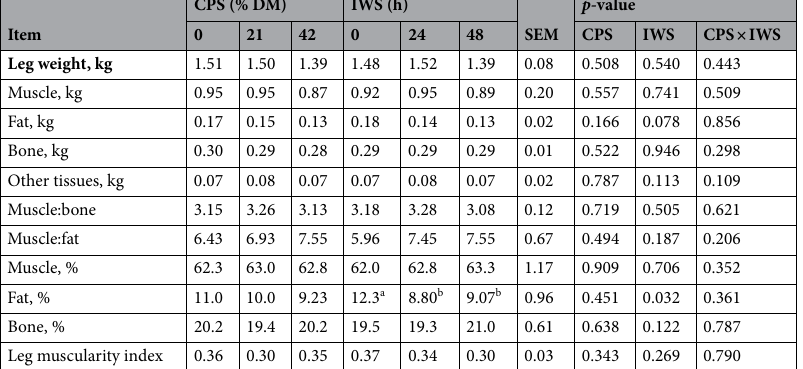
Table 3. Tissue composition and leg muscularity index of goats fed with cactus pear silage (CPS) and submitted to intermittent water supply (IWS). a,b Means within rows with different letter superscripts differ by Tukey test ( p <